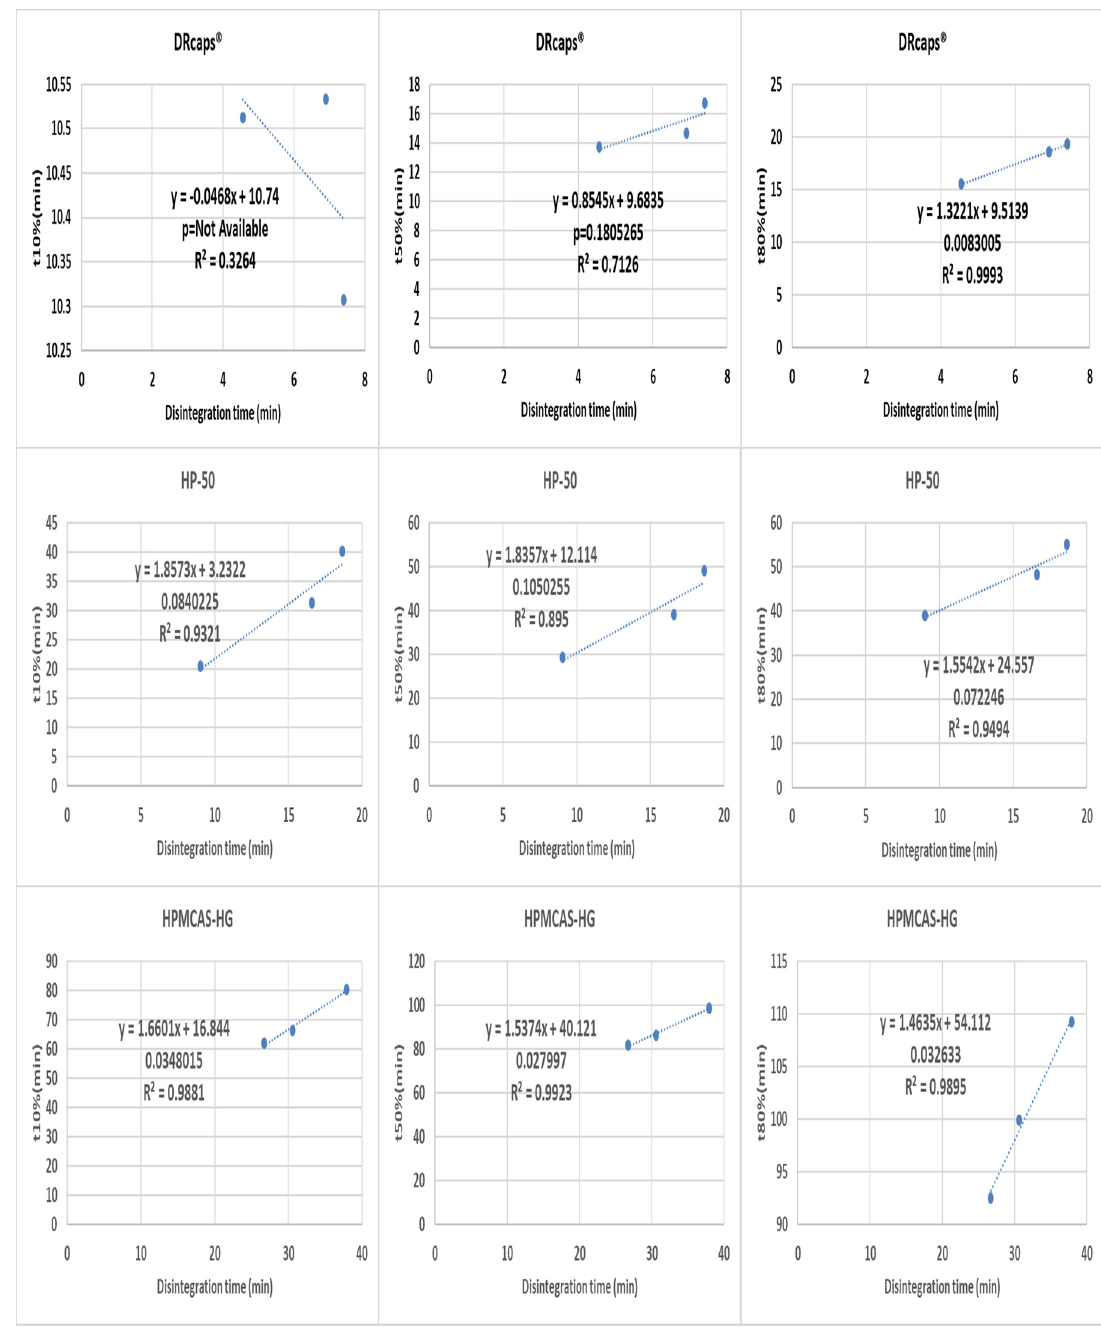
Figure 7. Correlating disintegration times with different dissolution (basket apparatus) parameters for one formulation in different media. The p -value is a one-sided value for a t -test applied to the slope.